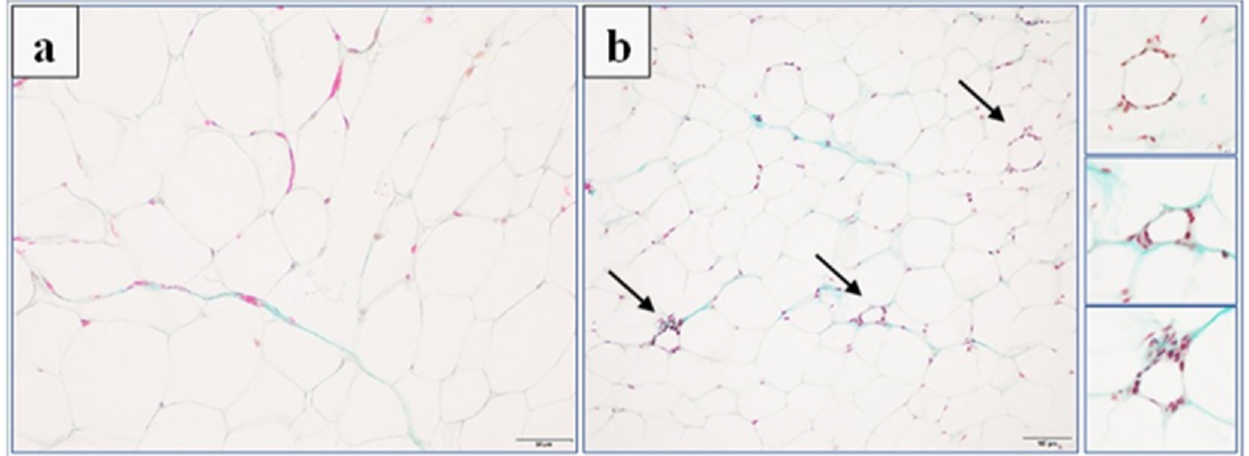
Figure 9. Histological section of adipose tissue from the palatable diet + phentermine 7 mg/kg group